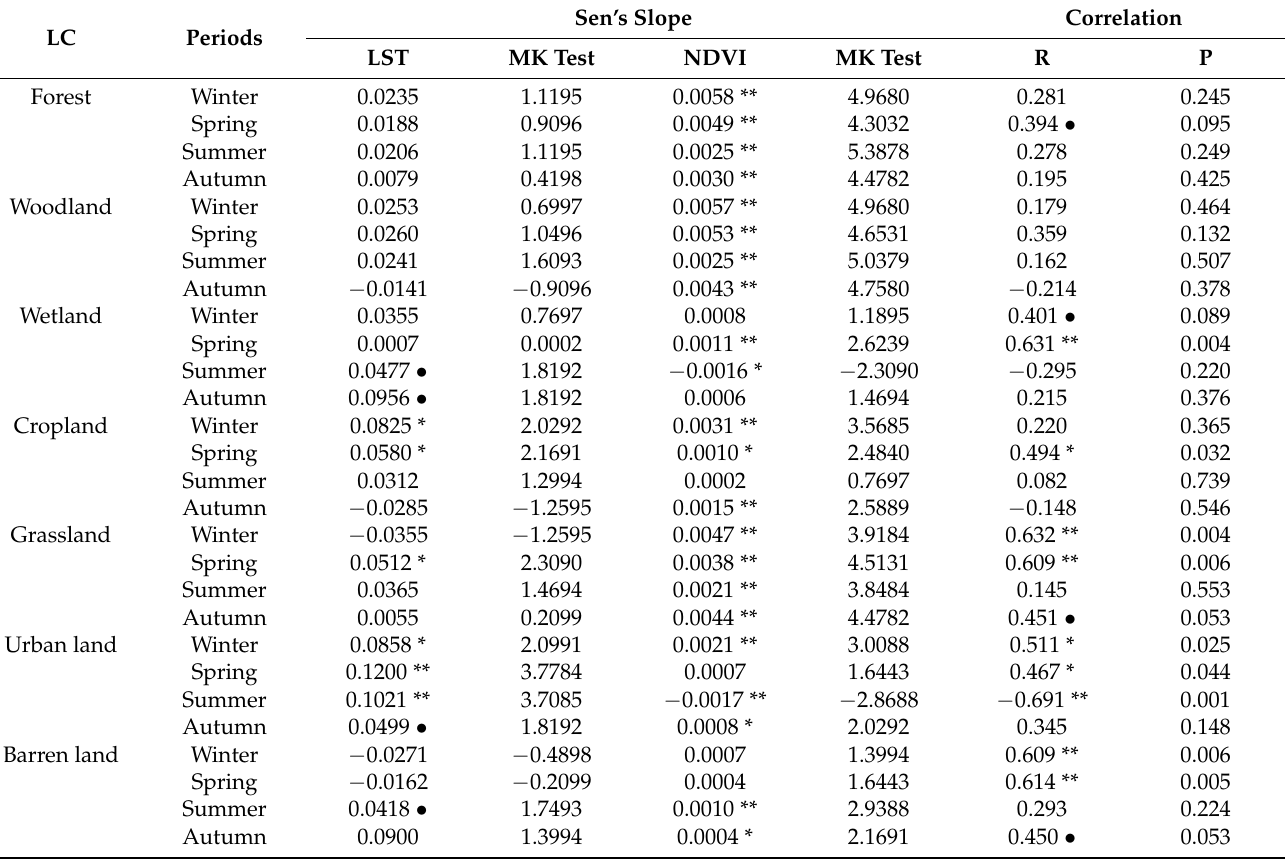
Table 3. Trends of LST ( ◦ C · yr − 1 ) and NDVI (yr − 1 ) in different land cover types (LC) from 2003 to 2021. Correlation coefficients ®of LST and NDVI in different land cover types for four seasons from 2003 to